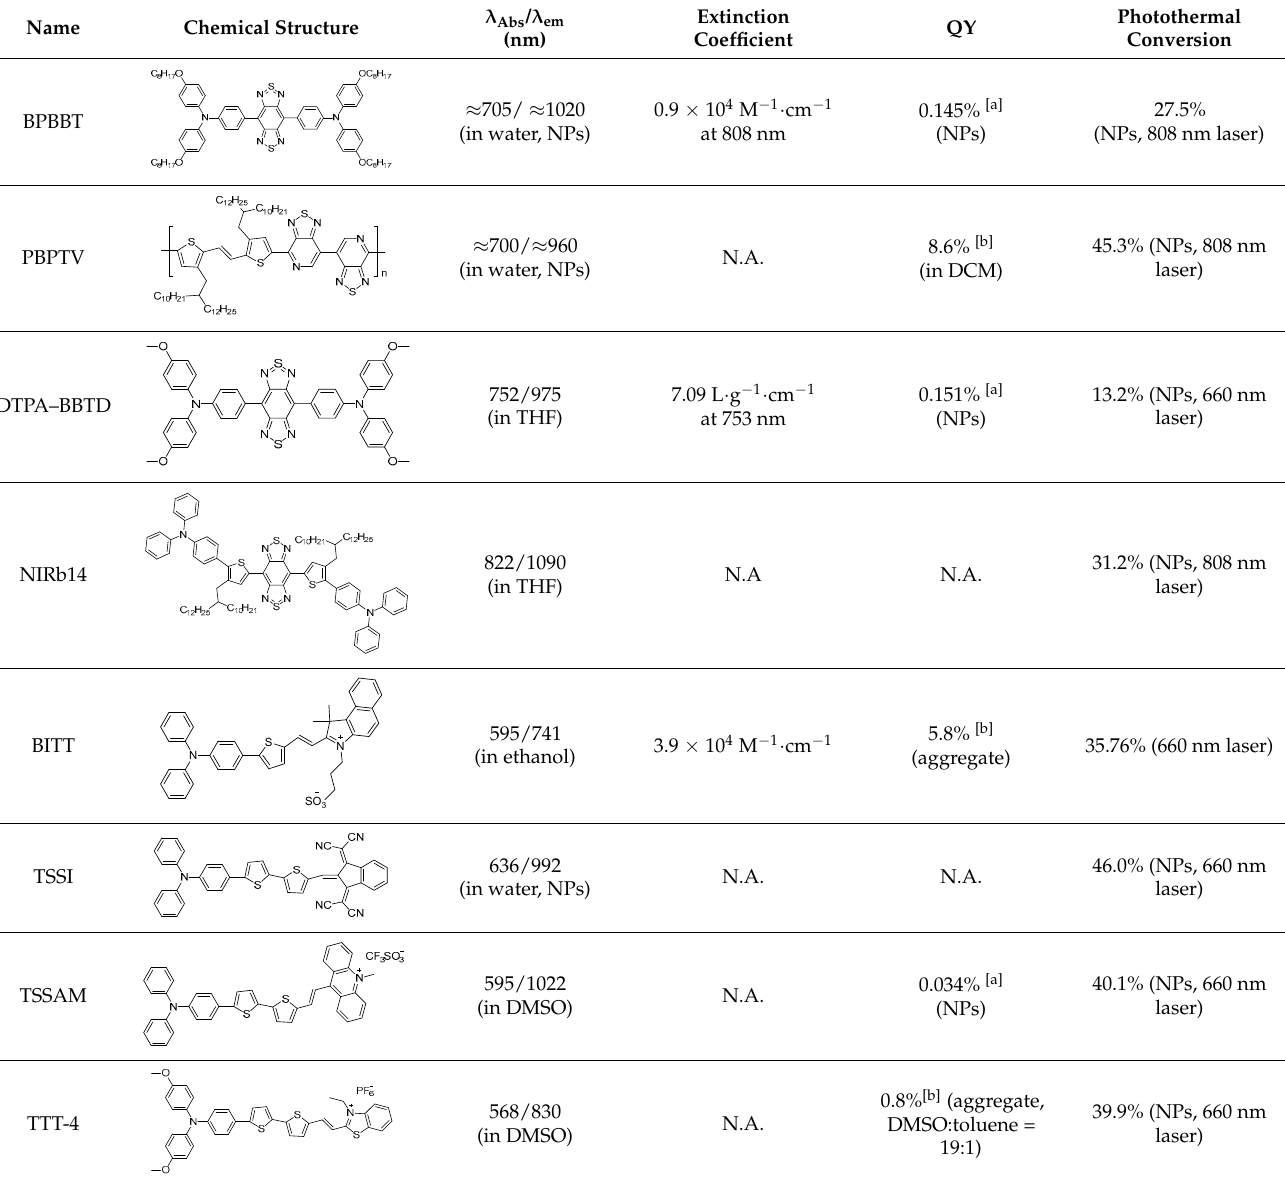
Table 1. The chemical structures and essential photophysical properties of NIR-II AIEgens.